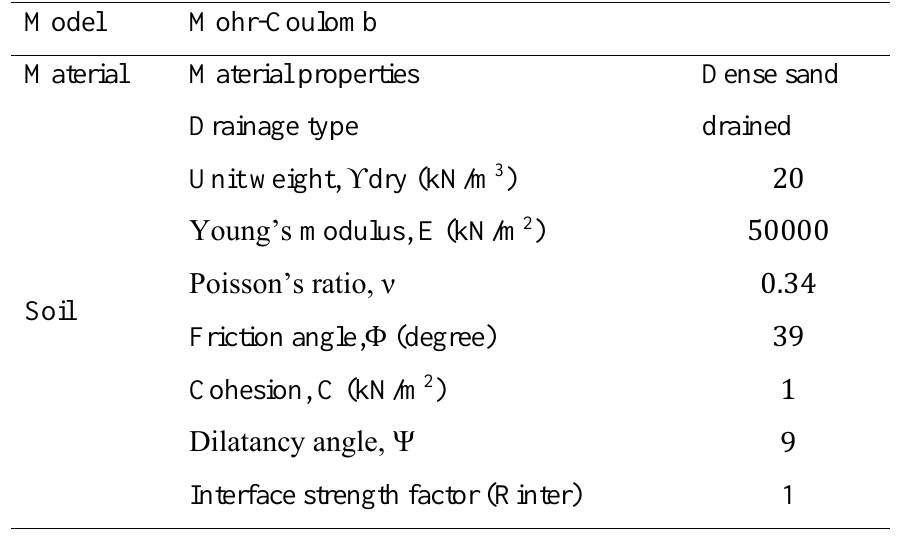
Table 2. Parameters of the studied